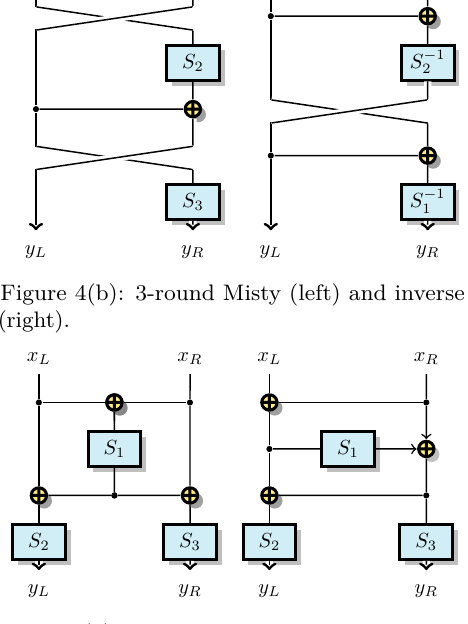
Figure 4(c): Bridge (left) and inverse (right). Figure 4(d): Littlun-like scheme equivalent rep-